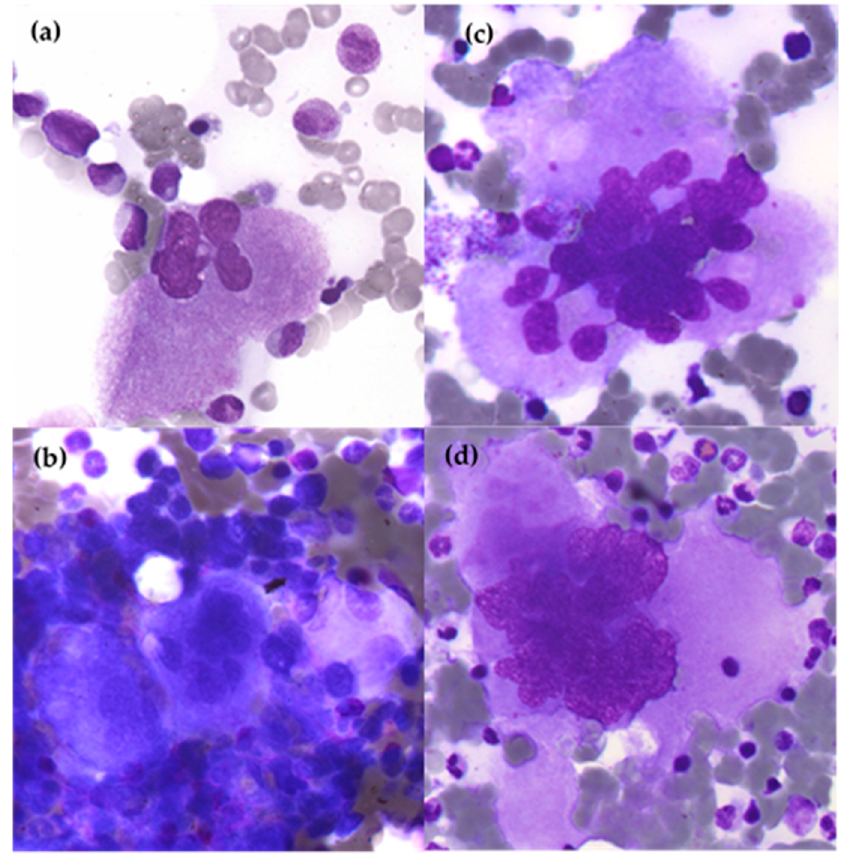
Figure 4. Cytological aspects of megakaryocytes in ET BM compared to physiological BM. ( a ) Physiological megakaryocyte in BM; ( b ) Cluster formation of megakaryocytes in BM ET; ( c , d ) Giant megakaryocytes and hypersegmented nuclei with « staghorn-like» aspect in ET BM. (optical microscopy, MGG and 100× magni fi cation).